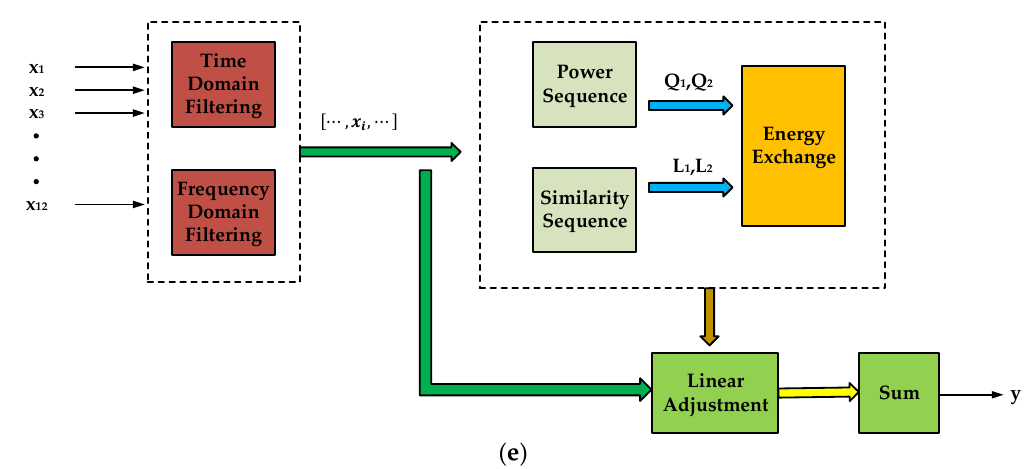
Figure 3. ( a ) Schematic diagram of the pulse wave signal processing flow; ( b ) block diagram of the Algorithm I process; ( c ) schematic diagram of spatial reconstruction of arrayed pulse wave signals; ( d ) block diagram of the Algorithm II process; ( e ) block diagram of the Algorithm III process.